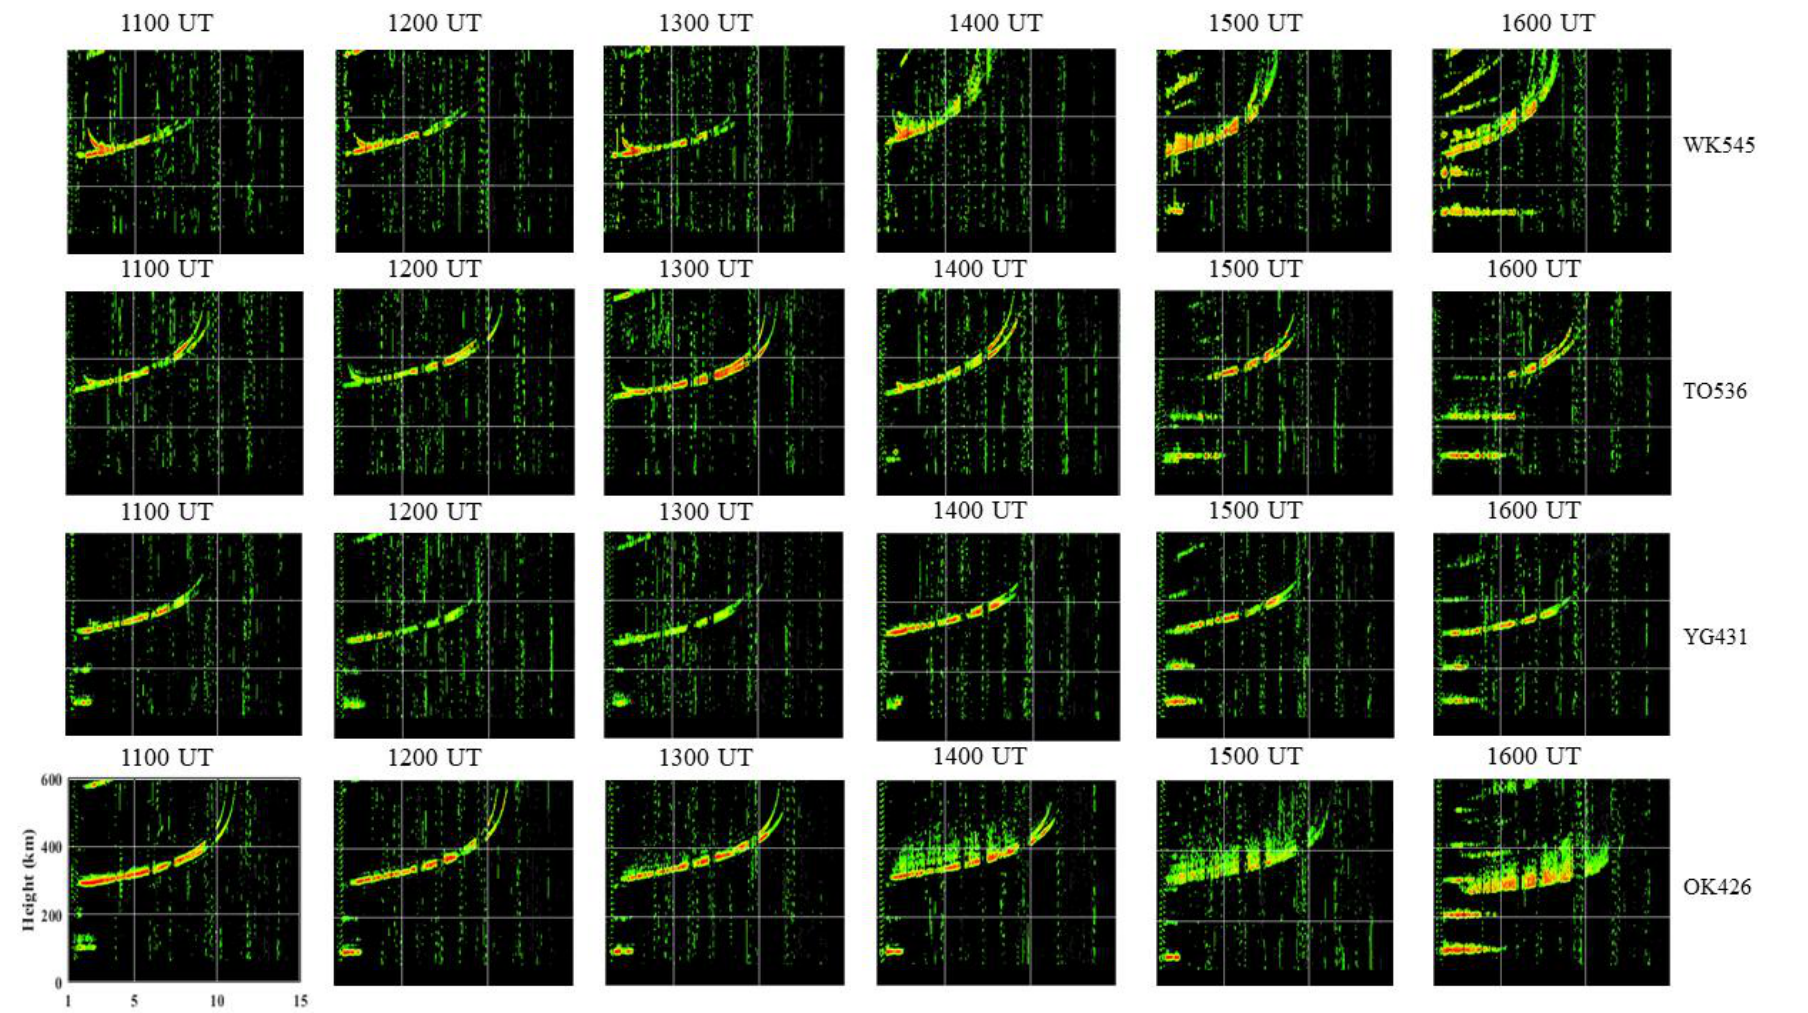
Figure 6. Development of spread F at ( top panel ) WK545, ( second panel ) TO536, ( third panel ) YG431, and ( bottom panel ) OK426 during 11 – 16 UT (20-01 JST) on 16 July 2003. Coordinate reference information is given in the lower left figure.